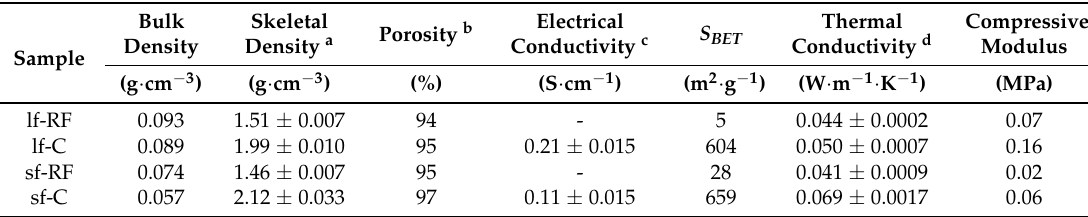
Table 1. General properties of synthesized